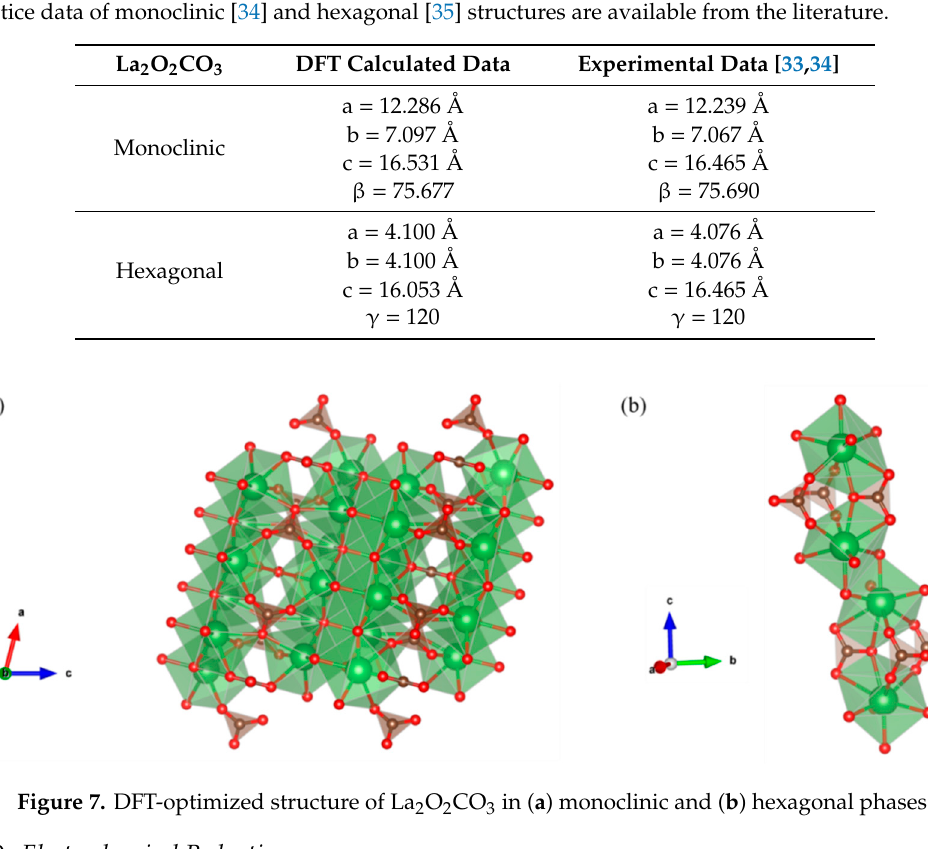
Figure 8. Linear sweeping voltammetry (LSV) curves of electrodes at various reaction times in a 0.1M NaHCO 3 solution at a scan rate of 20 mV/s: ( a ) PL-12h; ( b ) HL-12h.